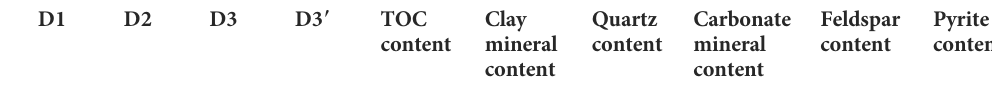
TABLE 1 The correlation analysis results of the fractal dimensions and different